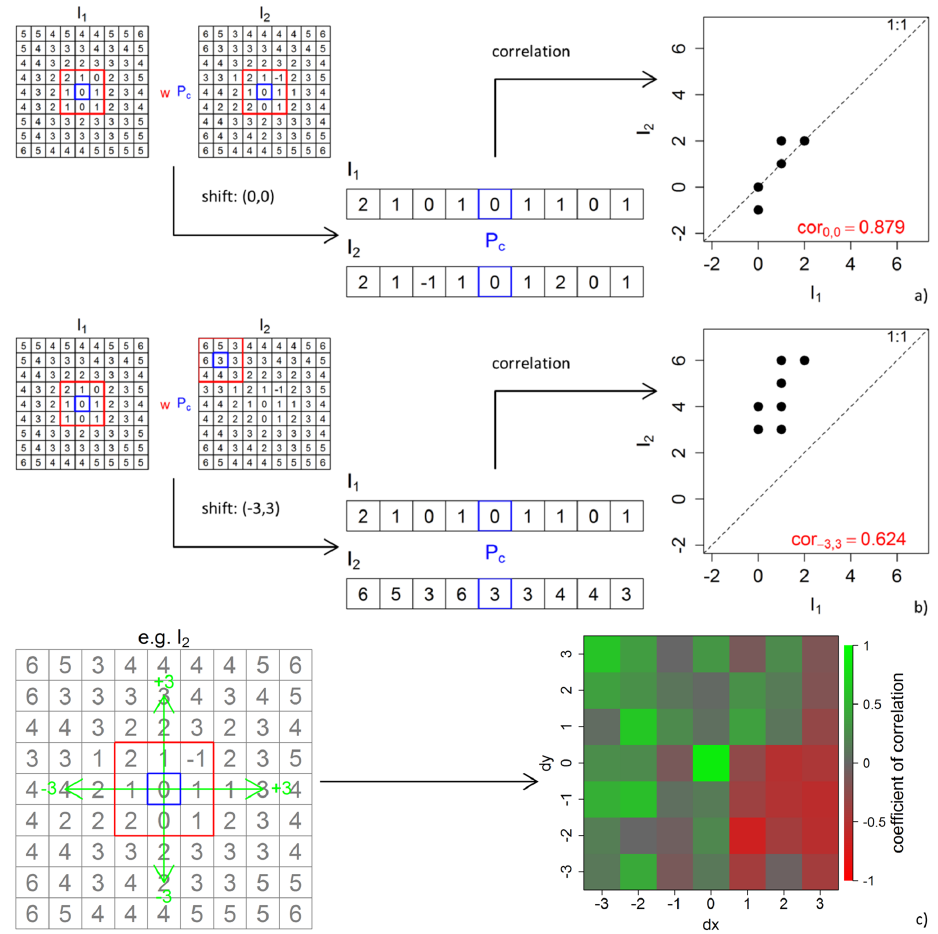
Figure 3. Analysis for the coefficient of correlation for a designed spatial data set. We added small normal distributed noise to the concentric spatial pattern I 1 to construct I 2 and show the correlation for an extracted window w (red) around the central pixel P c (blue) in the same position (a) , in different positions (b) and for the whole image I 2 within the maximum ranges [− 3 , + 3 ] (c)